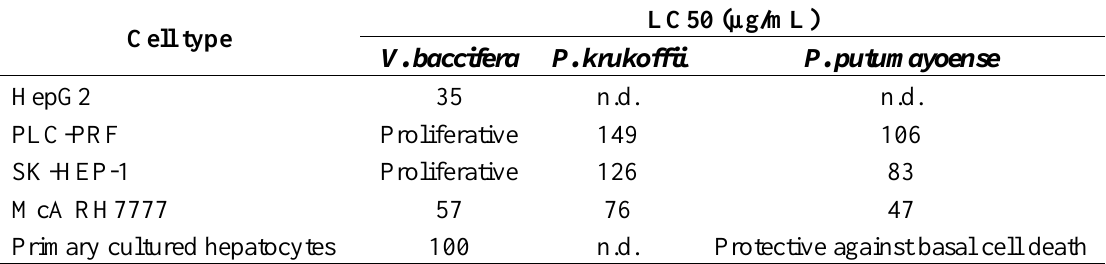
Table 1. Concentration (µg/mL) that causes 50% of cell toxicity (LC50) at 48